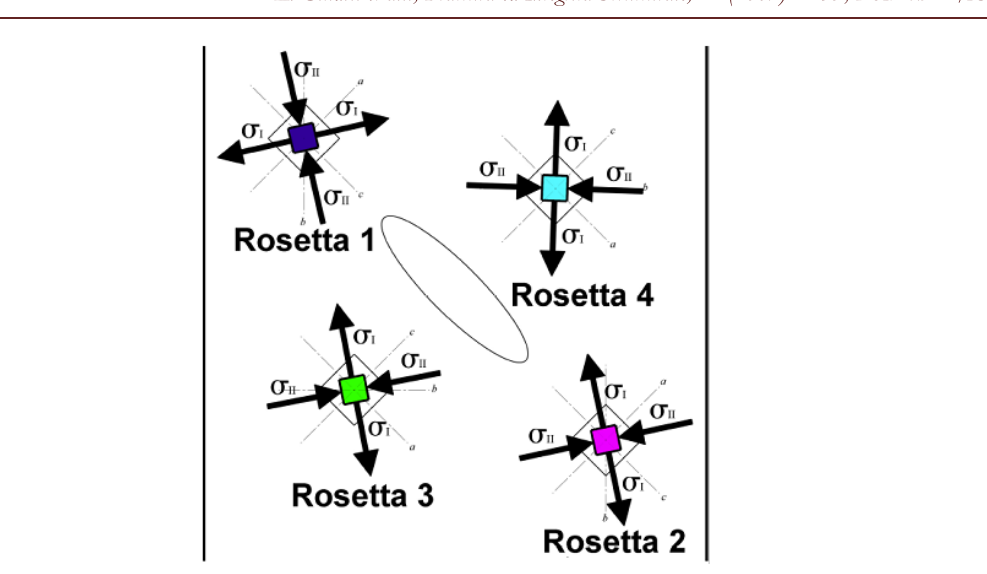
Figura 17: Direzioni principali degli sforzi rilevati durante la prova statica. Il proiettile è entrato nel componente in prossimità della rosetta 2 ed è uscito in prossimità della rosetta 1.